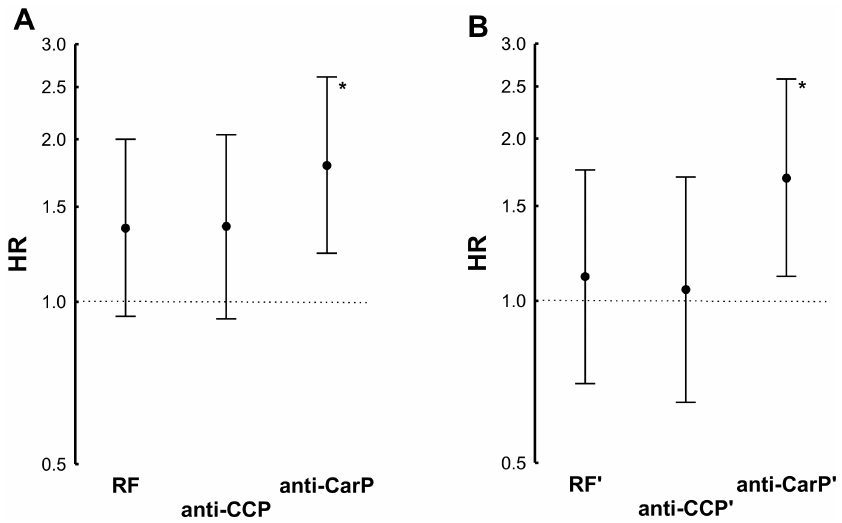
Fig 4. Comparison of the HR obtained by Cox proportional analysis of the three RA autoantibodies. (A) The three antibodies, RF, anti-CCP and anti-CarP, considered each of them separately; and (B) the three antibodies considered conditionalon the other two (indicated by the apostrophe, ‘, over them). Error bars correspond to the 95% CI. The asterisks, * , denotesignificantly increasedHR.